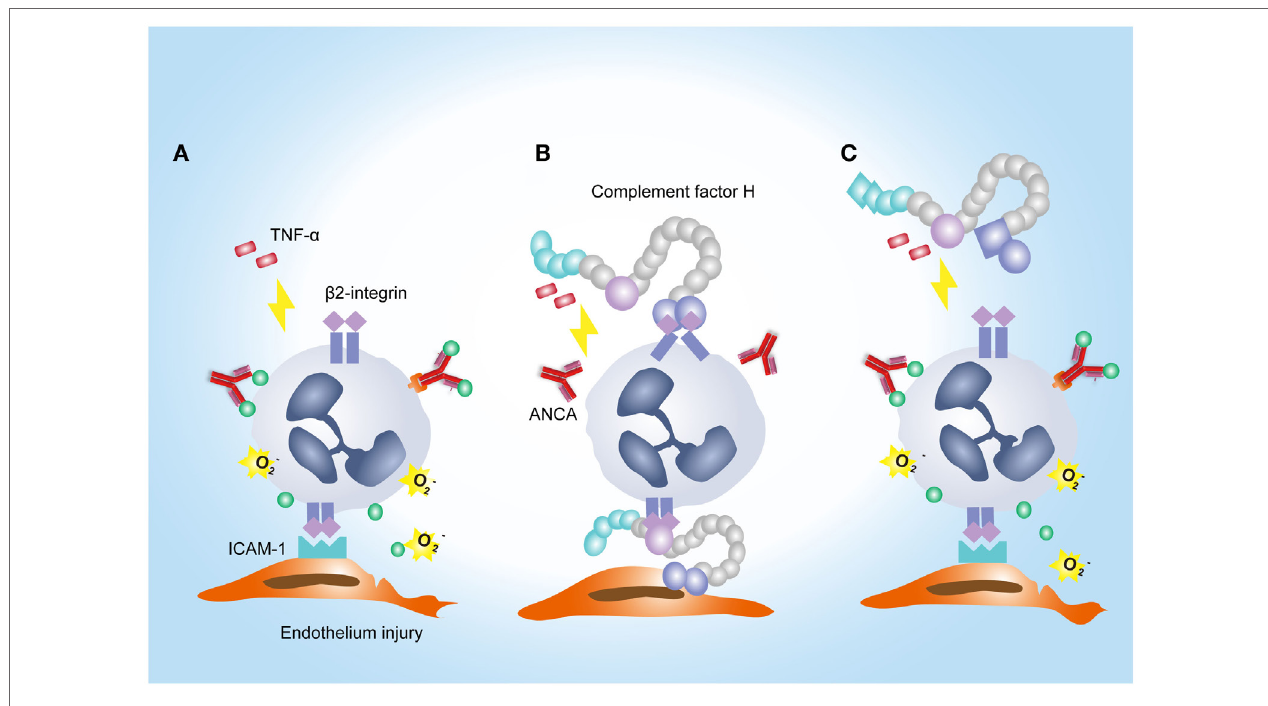
FigUre 7 | A proposed model of factor H (FH)–neutrophil interaction in the pathogenesis of anti-neutrophil cytoplasmic autoantibody (ANCA)-associated vasculitis (AAV). (a) TNF/ β 2-integrin joint signals triggers explosive responses of neutrophils adherent to endothelial cells in the presence of ANCA, resulting in degranulation and oxidative burst of neutrophils. (B) Binding of FH on neutrophils through β 2-integrin inhibits ANCA-induced activation of neutrophils. (c) In AAV, FH is deficient in binding neutrophils and inhibiting neutrophil activation by ANCA, which may be partly related to tyrosine nitration and chlorination of FH and genetic variations of